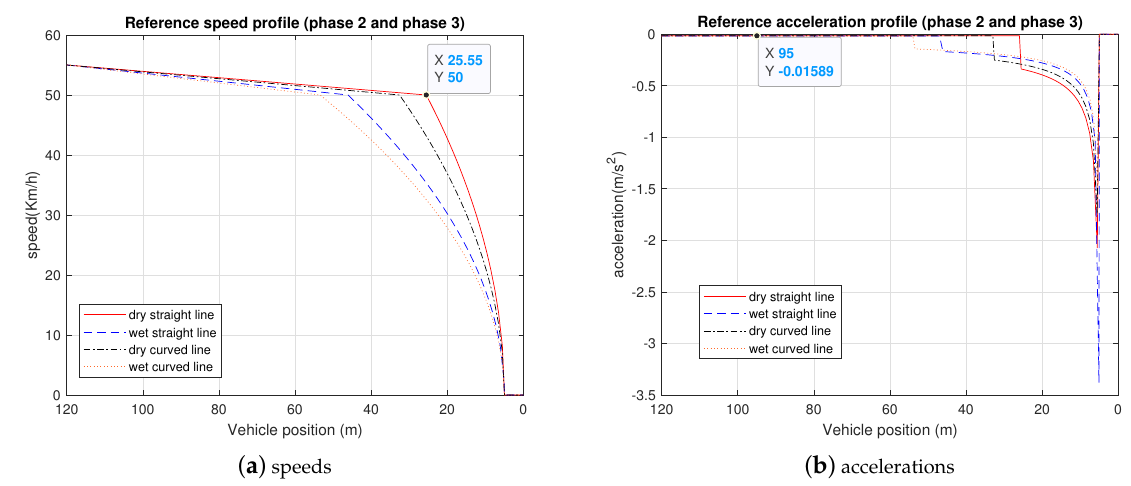
Figure 5. Speed and acceleration reference profiles: in the case of dry straight line (solid), wet straight line (dash-dot), dry curved line (dash), and wet curved line (dot).